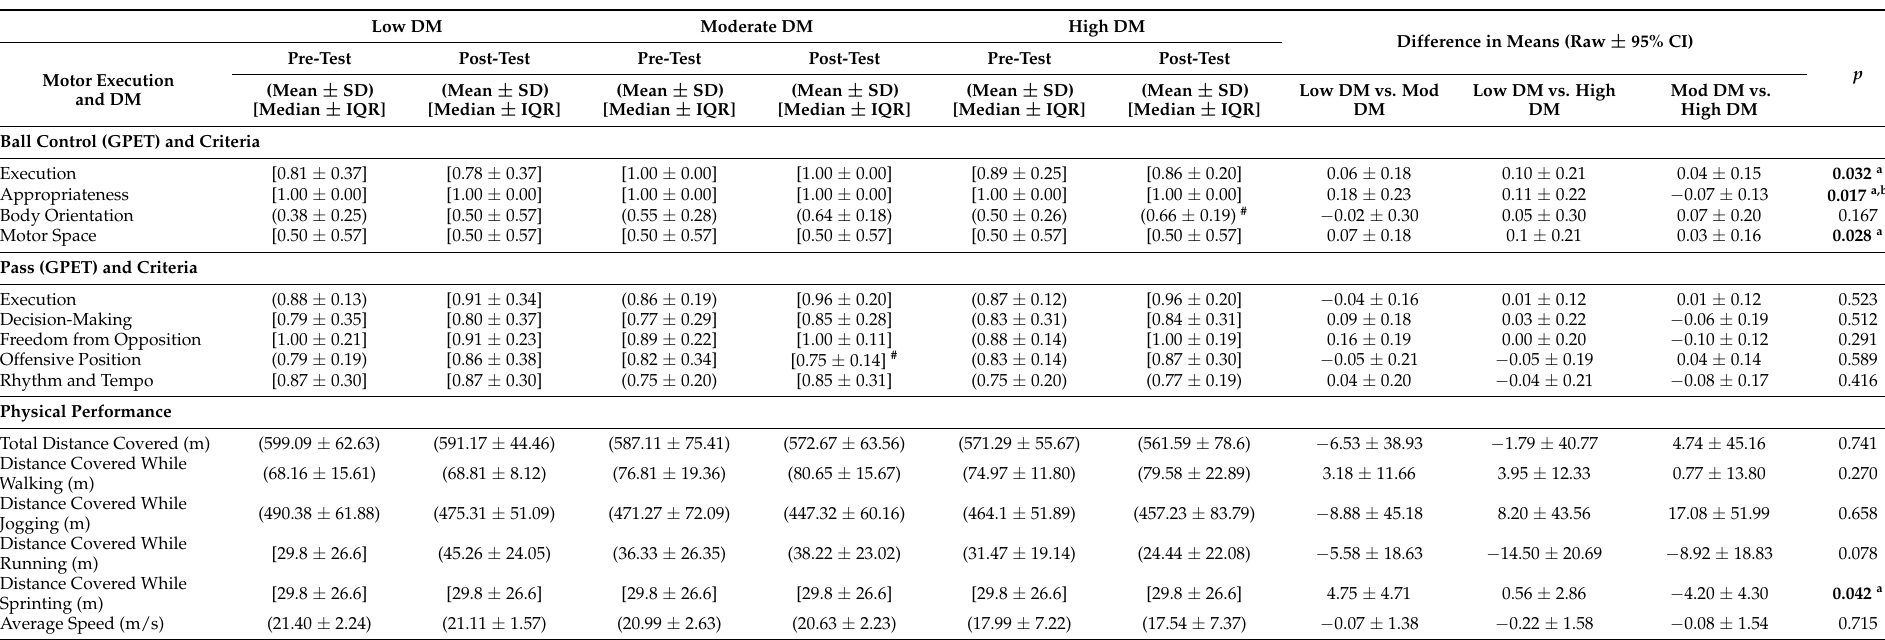
Table 2. Descriptive (M ± DP; Me ± IQR; Raw ± 95% CI) and inferential statistics from the passing intervention according to the conditions (Low DM, Mod DM, and High